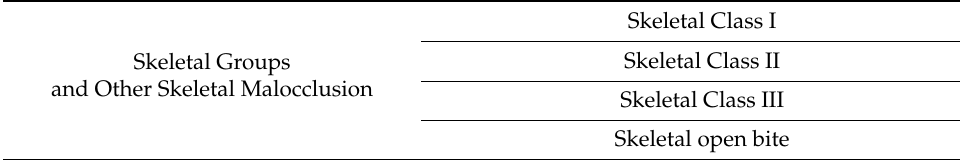
Table 1. The detailed variables subjected to the